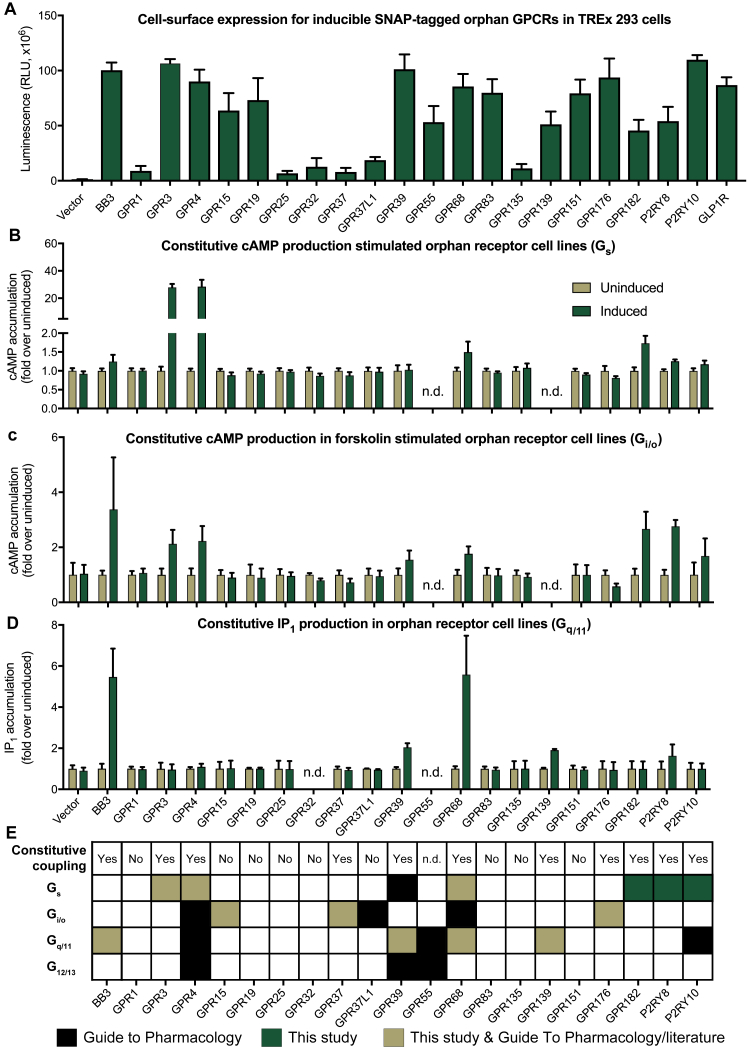
Receptor Expression and G Protein Coupling in Orphan GPCR Cell Lines, Related to Figure 4(A) Cell-surface expression of induced oGPCRs measured by ELISA. Data shown as mean ± SEM from n = 3-7 independent experiments performed in triplicate.(B-D) Constitutive cAMP and IP1 production (i.e., in the absence of ligand) upon orphan receptor induction provide insights into G protein-coupling. Data shown as mean ± SEM from n = 3-5 independent experiments, except for BRS3/BB3 (n = 2 in (B) and (C)), GPR32 (n = 2 in (B)) and GPR3 (n = 2 in (C)).(E) For three receptors, we discovered constitutive G protein-coupling unreported in Guide to Pharmacology or literature (Doi et al., 2016, Harding et al., 2018, Inoue et al., 2012, Martin et al., 2015, Muppidi et al., 2014, Pera et al., 2018, Suply et al., 2017), and for GPR15 robust Gi/o signaling in cAMP accumulation assays.